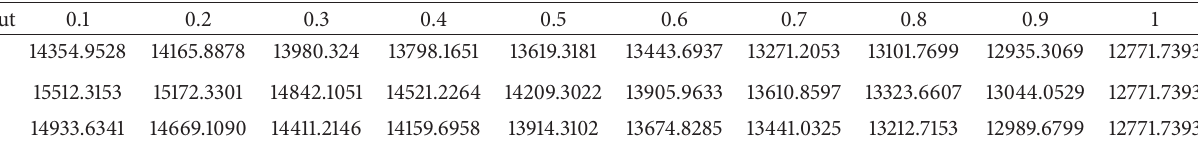
Table 2: Optimal solution at different possibility levels.